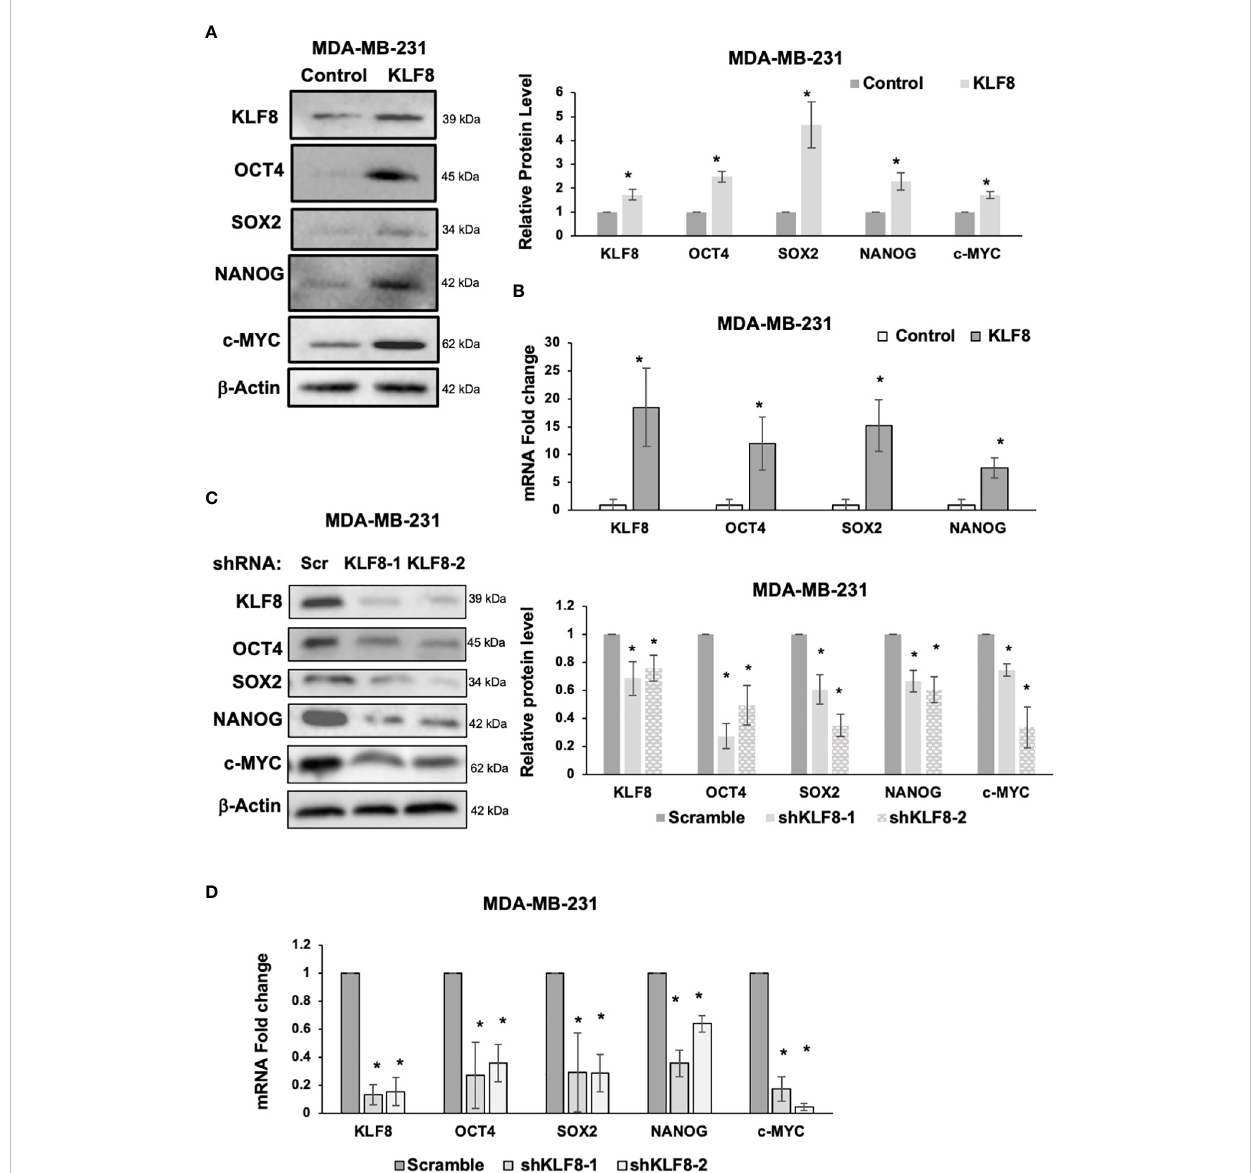
FIGURE 3 KLF8 regulates expression of stem cell markers in breast cancer cells. (A) Lysates from MDA-MB-231 cells stably overexpressing control or KLF8 were collected for immunoblot analysis of CSCs markers using indicated antibodies (left), and quanti fi ed graph of relative level of CSCs detected by immunoblot from MDA-MB-231 cells control or with KLF8 overexpression (right). (B) Quanti fi ed graph showing relative mRNA level of CSCs markers as detected by qRT- PCR using probes against genes in MDA-MB-231 cells stably overexpressing control or KLF8. (C) Lysates from MDA-MB-231 cells stably expressing control or KLF8 shRNA were collected for immunoblot analysis of CSCs markers using indicated antibodies (left), and quanti fi ed graph of relative level of CSCs levels (right). (D) Quanti fi ed graph showing relative mRNA level of CSCs markers as detected by qRT-PCR using probes against indicated targets in MDA-MB-231 cells stably expressing control or KLF8 shRNA. Student t test reported as mean ± SEM,